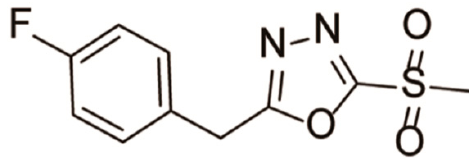
Figure 1. Chemical structure of FBEZF.